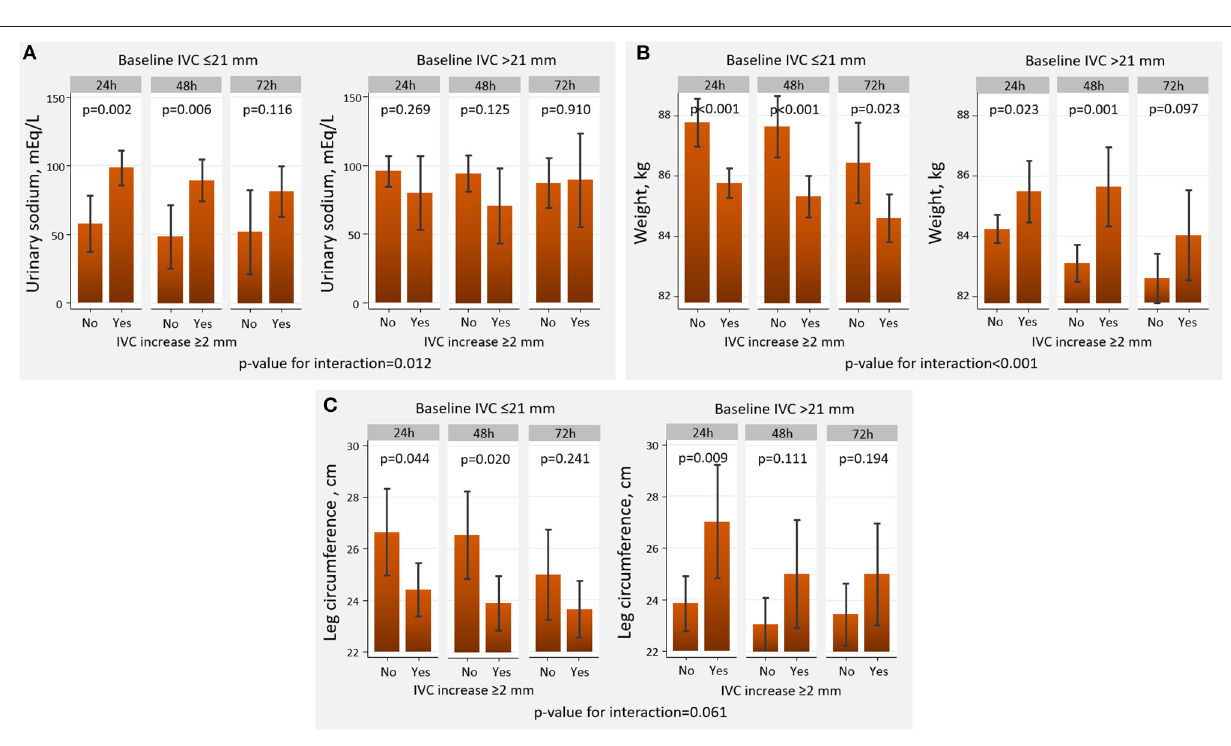
Dyspnea VAS NT-ProBNP